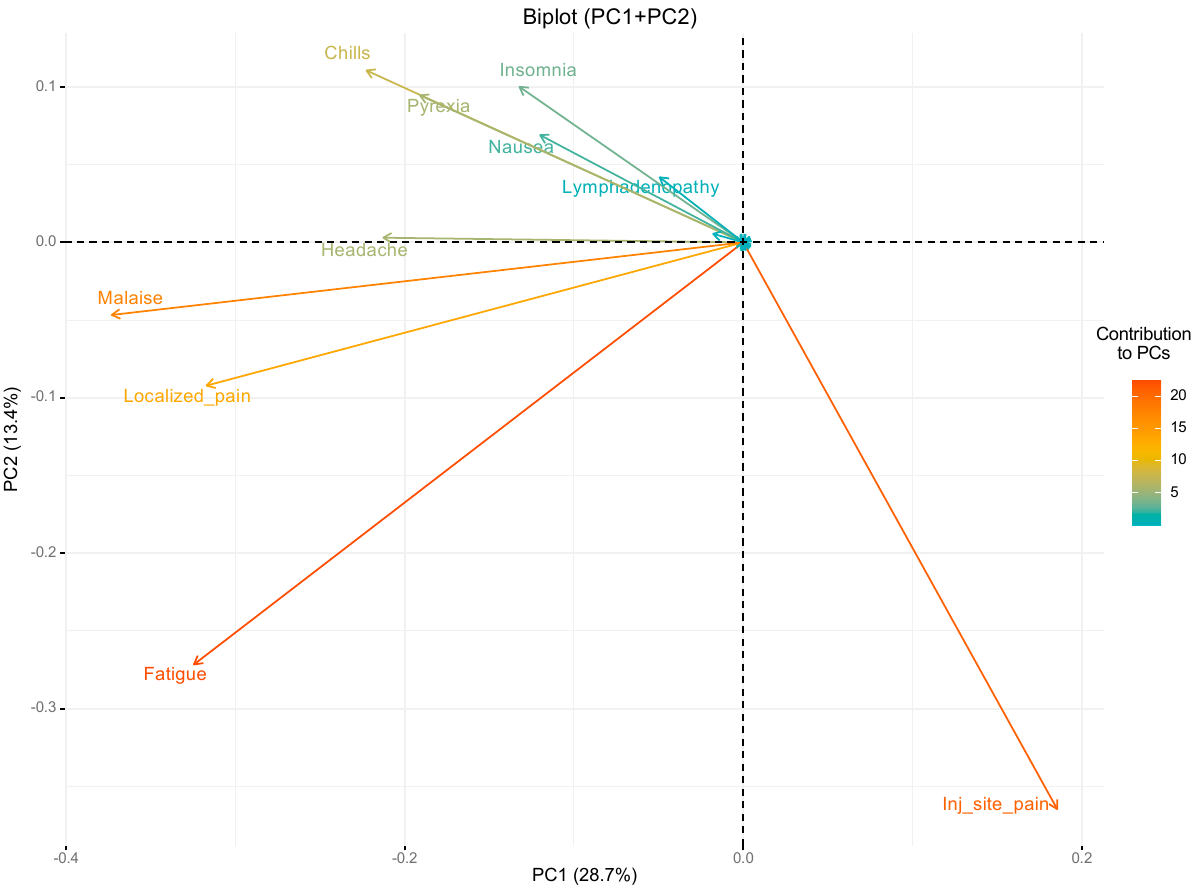
Figure 1. Biplot between PC1 and PC2 showing contribution of different vectors (i.e., reported adverse events) on the identified principal components. Only vectors that provide stronger contributions are reported.